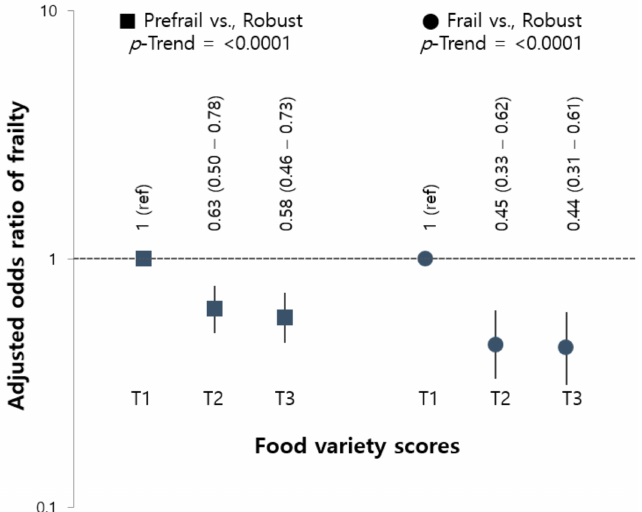
Figure 1. Adjusted ORs (95% CI) for pre-frailty and frailty according to the tertile of food variety scores. Ref.: reference category; OR: odds ratio; CI: confidence interval. Data were calculated using the multinomial SURVEYLOGISTIC model. ORs (95% CIs) were adjusted for gender, age, BMI, living status, residential area, family income, education level, smoking status, high-risk alcohol consumption, comorbidity, and energy